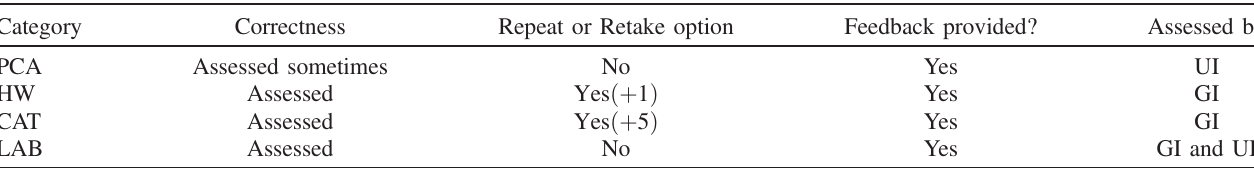
TABLE II. The CB model course evaluation structure. PCA, HW, CAT, and LAB stand, respectively, for preclass assignments, homework, content area test and laboratory. All assignments were hand graded by multiple instructors following rubrics. GI and UI stand for graduate instructors and undergraduate instructors,